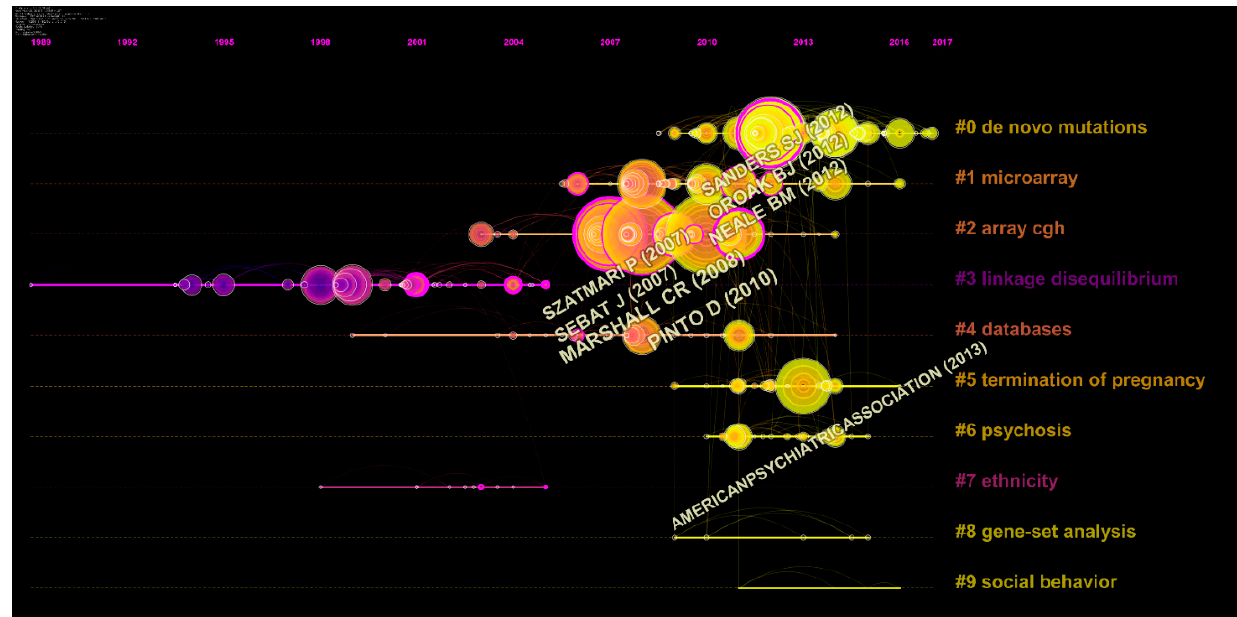
Figure 5. Co-cited references timeline map based on CiteSpace. Co-cited references that are commonly cited in the literature of genetic factors in ASD are clustered and identified by CiteSpace. Nodes on the map represent referenced documents. The shift of research concerns was reflected by the trend of co-cited literature subjects. Years are arranged horizontally at the top, and the label of each cluster is shown at the end of the cluster’s timeline.